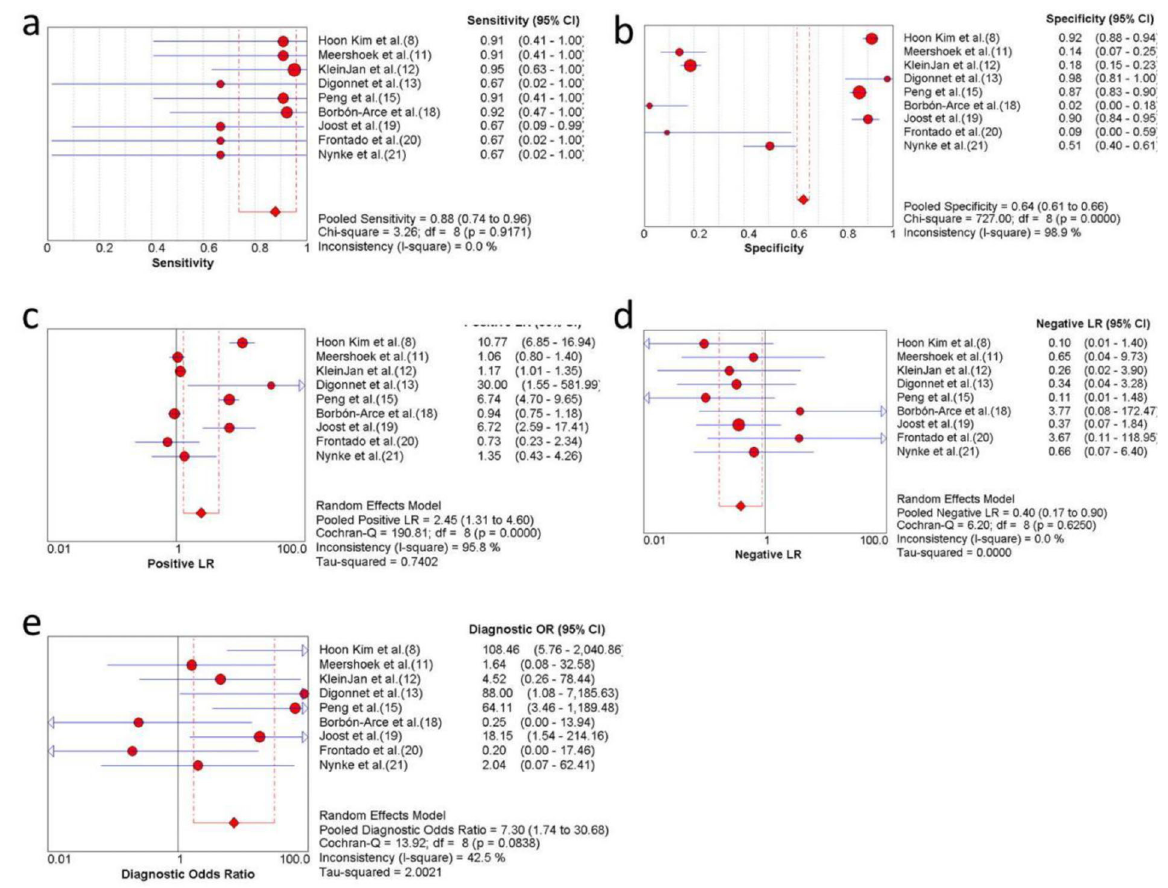
Figure 4 - Forest plots of ICG NIR fluorescence imaging in oral cavity cancer (a) sensitivity, (b) specificity, (c) PLR, (d) NLR, and (e) DOR. DOR, Diagnostic odds ratio; ICG, indocyanine green; NIR, near-infrared; NLR, negative likelihood ratio; PLR, Positive likelihood